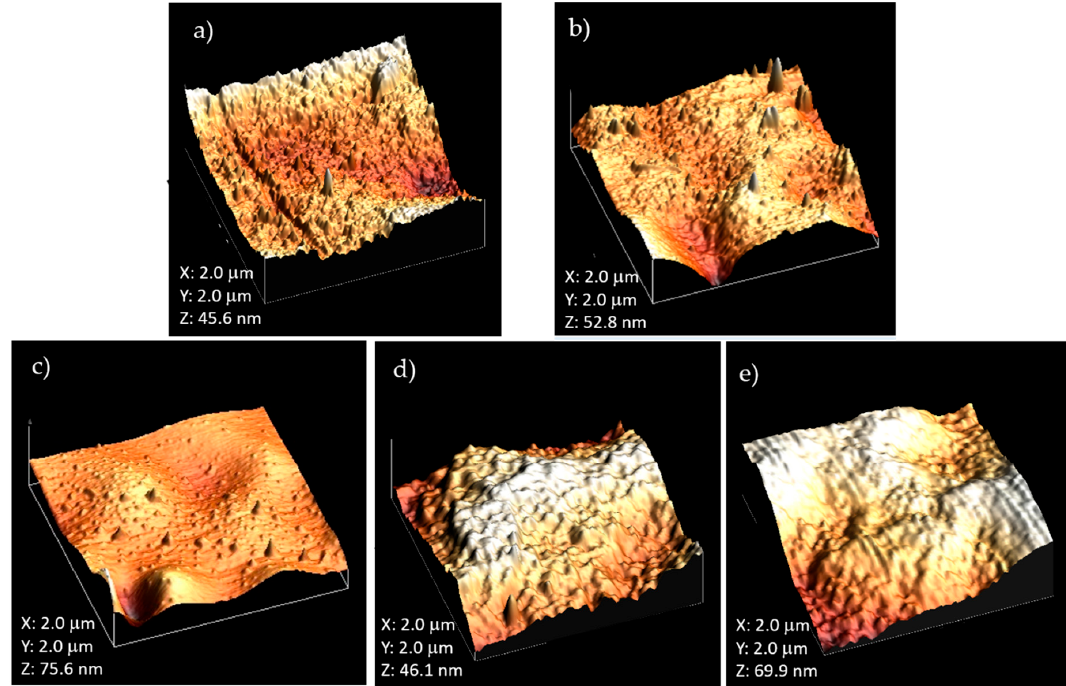
Figure 5. Atomic Force Microscopy (AFM) topographic images of bottom side of PSf-mG20 membranes: ( a ) L0; ( b ) L2; ( c ) L5; ( d ) L10; ( e ) L20. Table 2. RMS roughness of bottom side, water contact angle (CA) and Water Uptake (WU) of PSf- mG20 membranes.